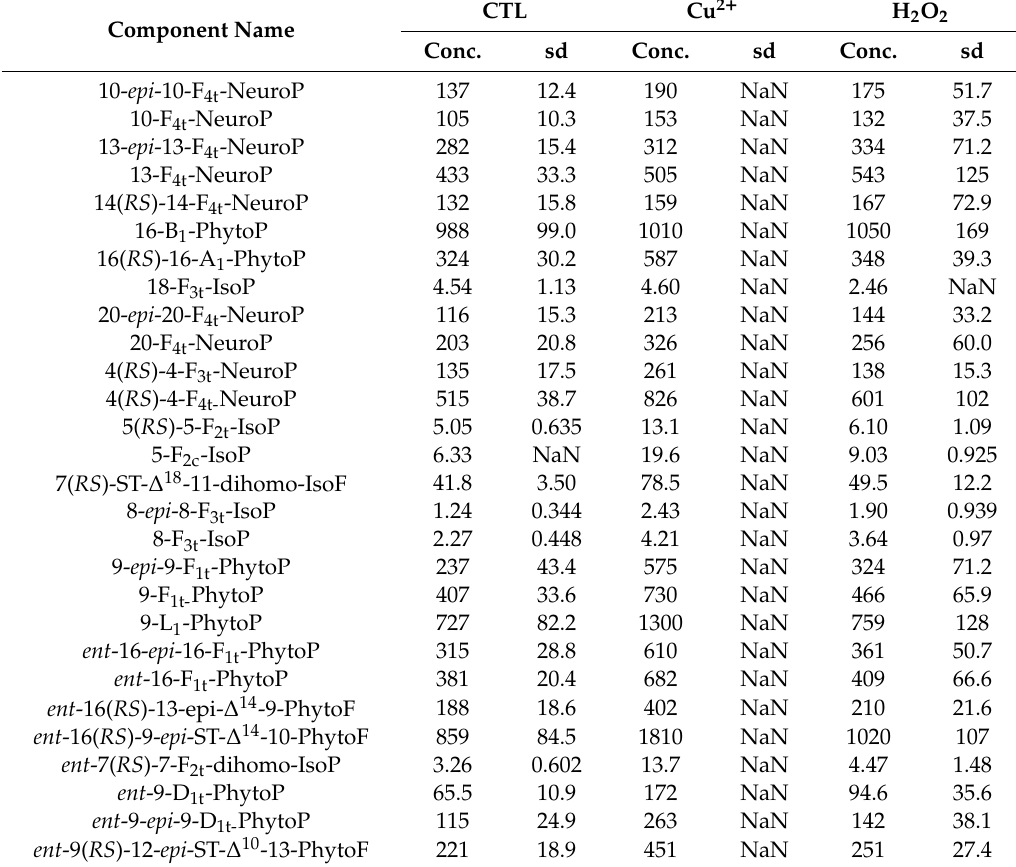
Table 3. Quantification of NEO-PUFAs in T. lutea incubated under control, copper or H 2 O 2 stress conditions. Data are mean ± sd (n = 3, except for copper stress: n = 2) expressed as ng / g dry weight. NaN stands for Not a Number, because it is an impossible